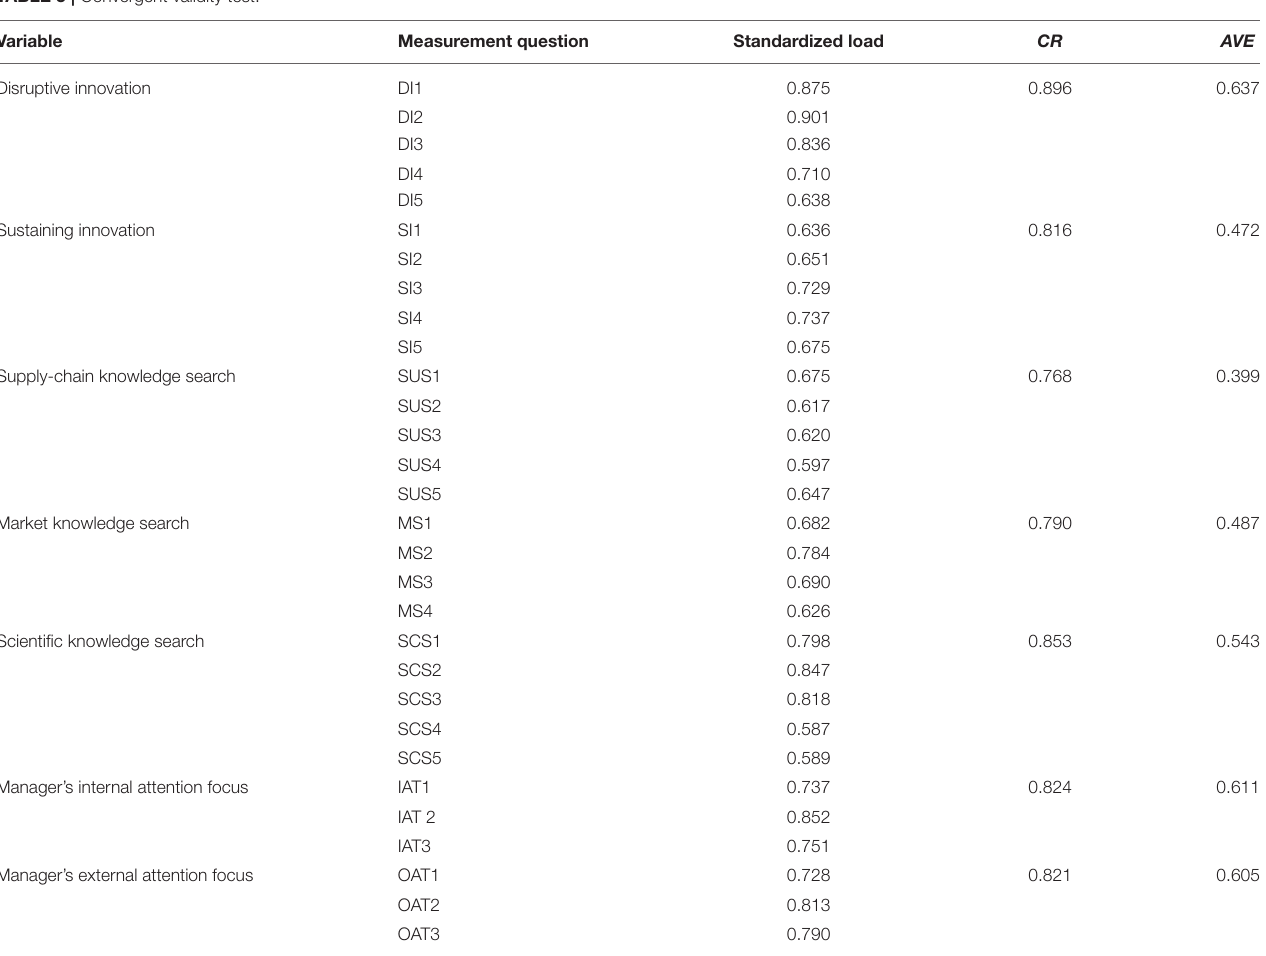
TABLE 3 | Convergent validity test.